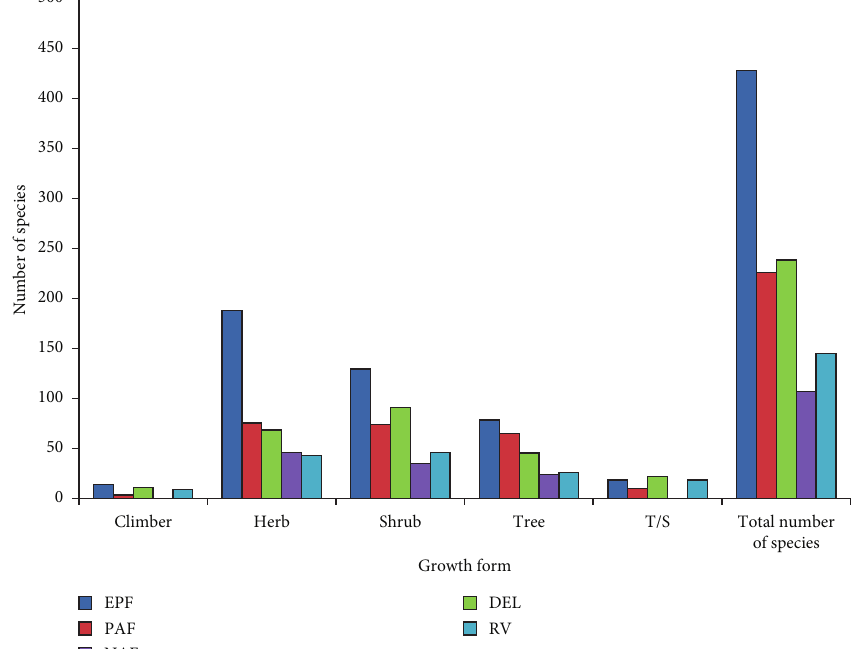
Figure 2: Number of species and growth form in different land-use types. Note: the same species were counted repeatedly in five land-use types. Table 2: Shannon, evenness, Simpson’s indices and species richness for the land-use categories. Total area Land-use category No. of plots (ha)